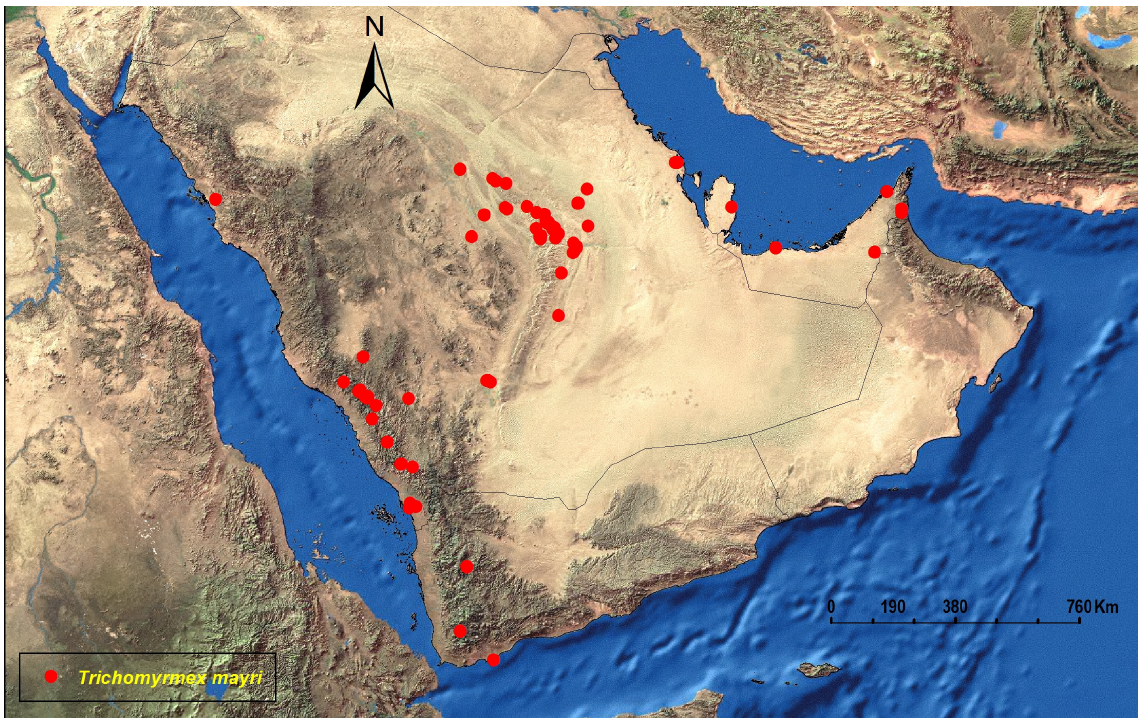
Fig. 16. Distribution map of Trichomyrmex mayri (Forel, 1902).